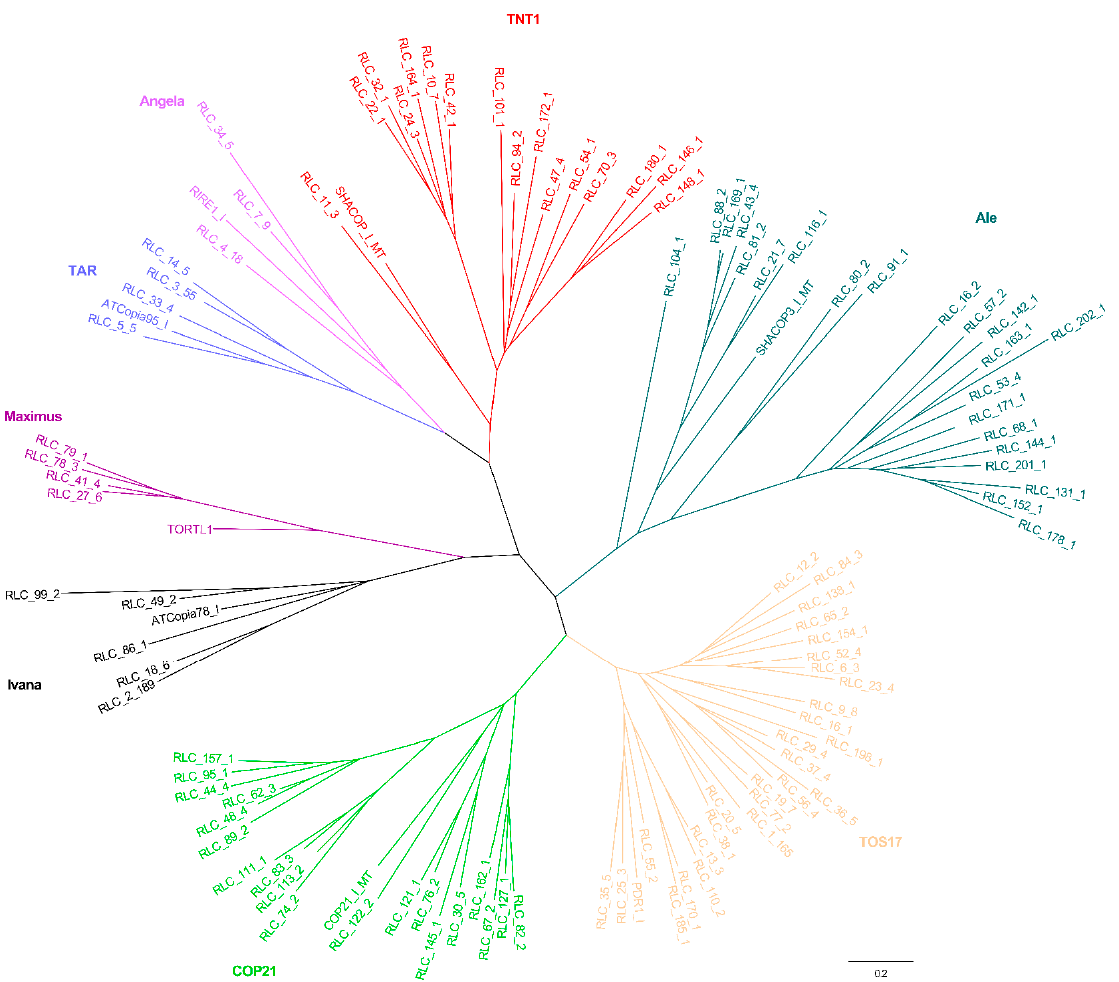
Figure 3. RT phylogenetic tree of Copia and representative members of the Copia lineages. Maximum-likelihood tree with representative RT sequences of each family and the representative members of Copia lineages. In the tree, each family is marked by its name. Representative sequences that were reported in previous studies were selected. Nucleotide sequences of RT of the individual families were aligned by MUSCLE (v.3.8.31). After best-fit models were evaluated by MEGA6, these sequences were used to construct the phylogenetic trees based on the maximum-likelihood method. The entire lineages are shown with different colors: Red, TNT1; Sapphire, TAR; Purple, Angela; Pale purple, Maximus; Black, Ivana; Green, COP21; Orange, TOS17; and Emerald green, Ale. Locus name of representative members of Copia lineages in Repbase (https://www.girinst.org/): ATCopia78_I, TORTL1, ATCopia95_I, RIRE1_I, SHACOP_I_MT, SHACOP3_I_MT, PDR1_I, and COP21_I_MT.